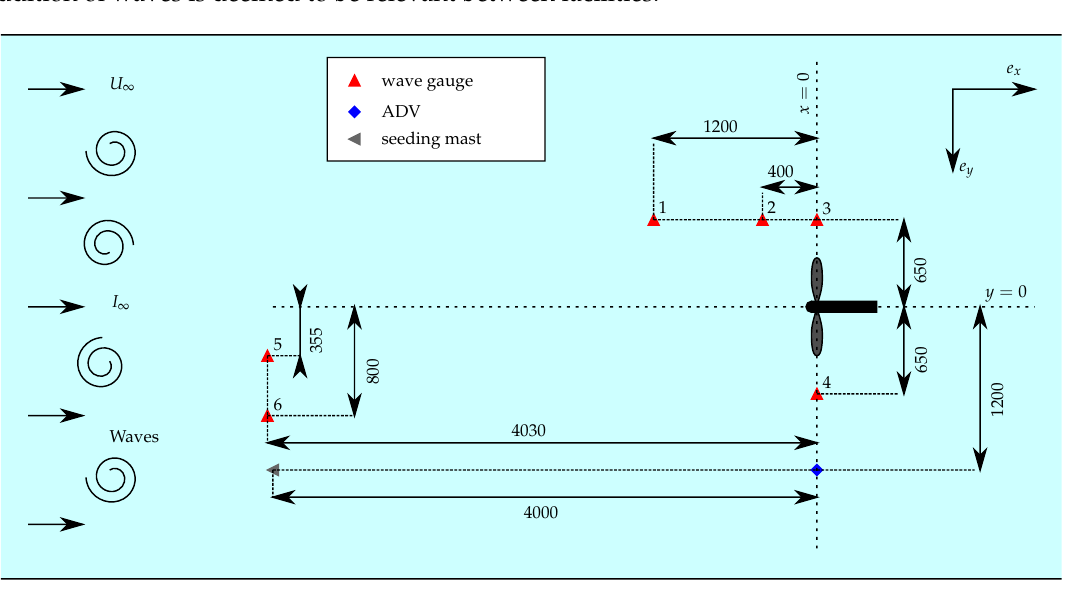
Figure 6. Schematic top-view of the test set-up used in the tanks. ADV is used in every tank but the seeding mast is required at C NR -I NM only. The wave gauges 1 to 3 are used at I FREMER and F LO W AVE . Wave gauges 3 to 6 at C NR -I NM . Dimensions are given in mm and the presented tank width represents the I FREMER